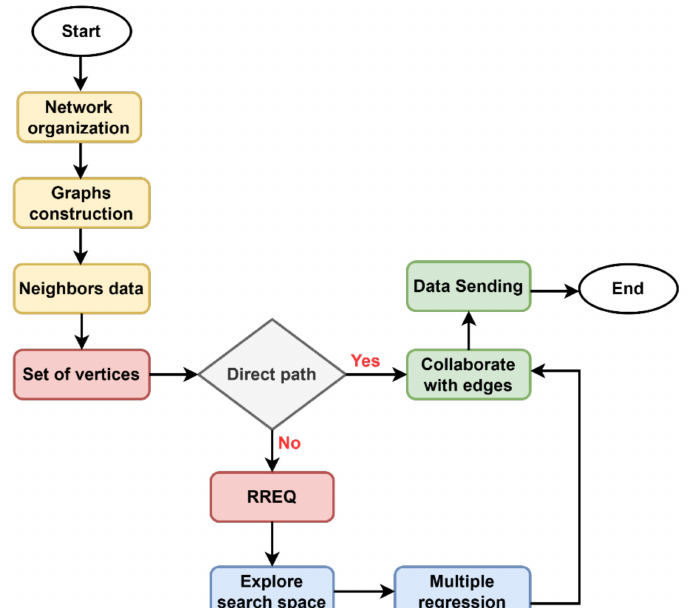
Figure 1. Smart random walk routing with the multi-regression